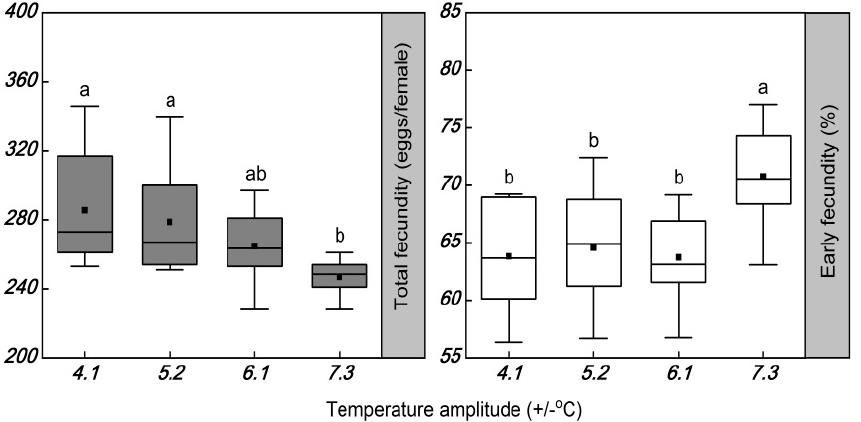
Figure 3. Box plot of the total fecundity and early fecundity in Plutella xylostella developed under four daily temperature amplitudes, with a similar mean temperature. The upper and lower boundary of the box indicate the 75th percentile and 25th percentile of the data set. The black horizontal line and black square within the box represent the median and mean values. Error bars above and below the box indicate the minimum and maximum values, respectively. Different letters above each box indicate significant differences ( p < 0.05) among the treatments.